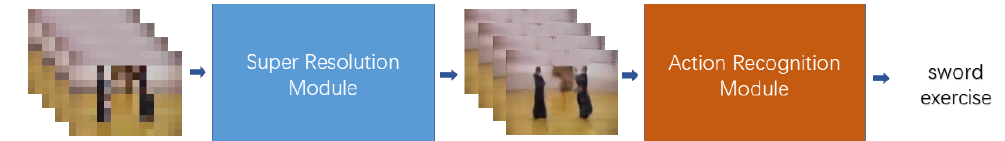
Figure 1. The overview of our